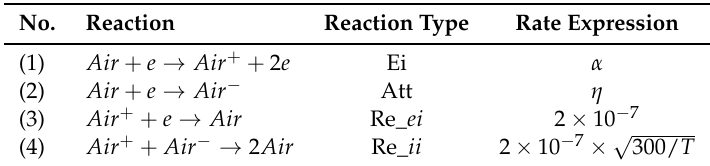
Table 1. Reaction mechanism. Ei denotes the electronic ionization. Att denotes the attachment. Re_ ei and Re_ ii denote the recombination of electron–ion and ion–ion,